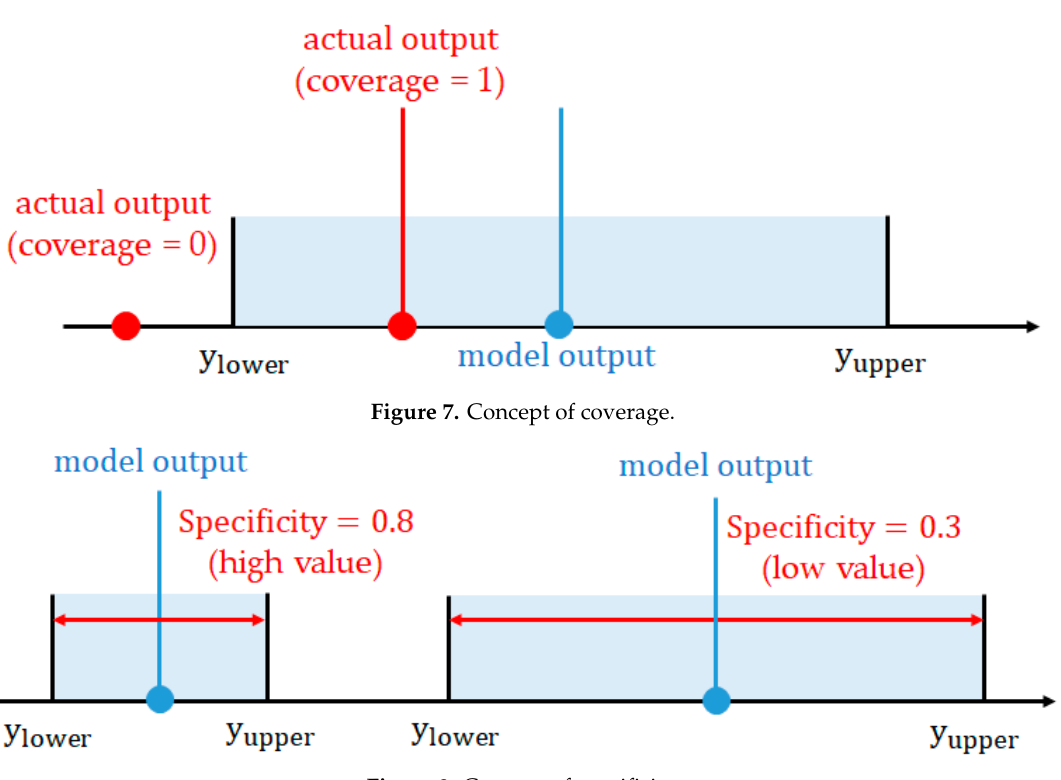
Figure 8. Concept of specificity.